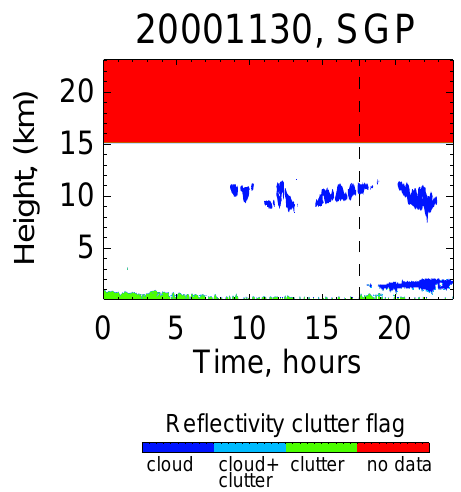
Fig. 3. Radar cloud mask for 20 November 2000, with clouds in dark blue, clutter in green, mix of clutter and hydrometeors in light blue and no returns in red. The dashed line represents the MODIS start time of acquisition over the site. This figure illustrates the complexity of some scenes where two different cloud layers appear above the radar beam at different times but will be present close to the site in the satellite